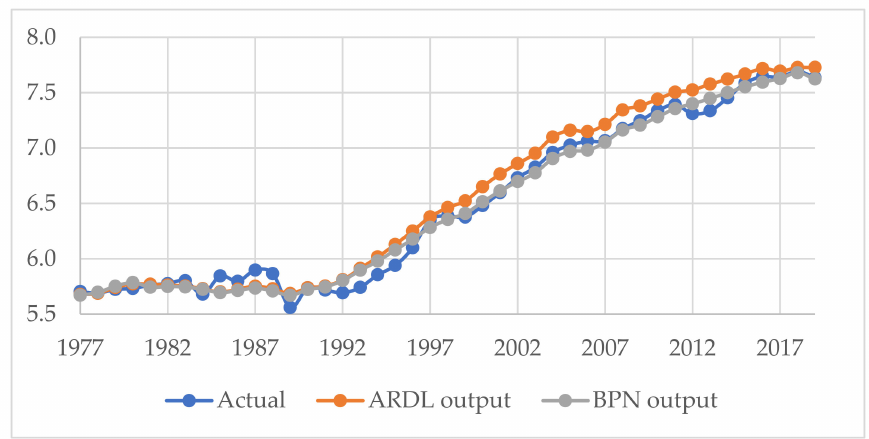
Figure 6. CO 2 emissions predicting results for both BPN and ARDL